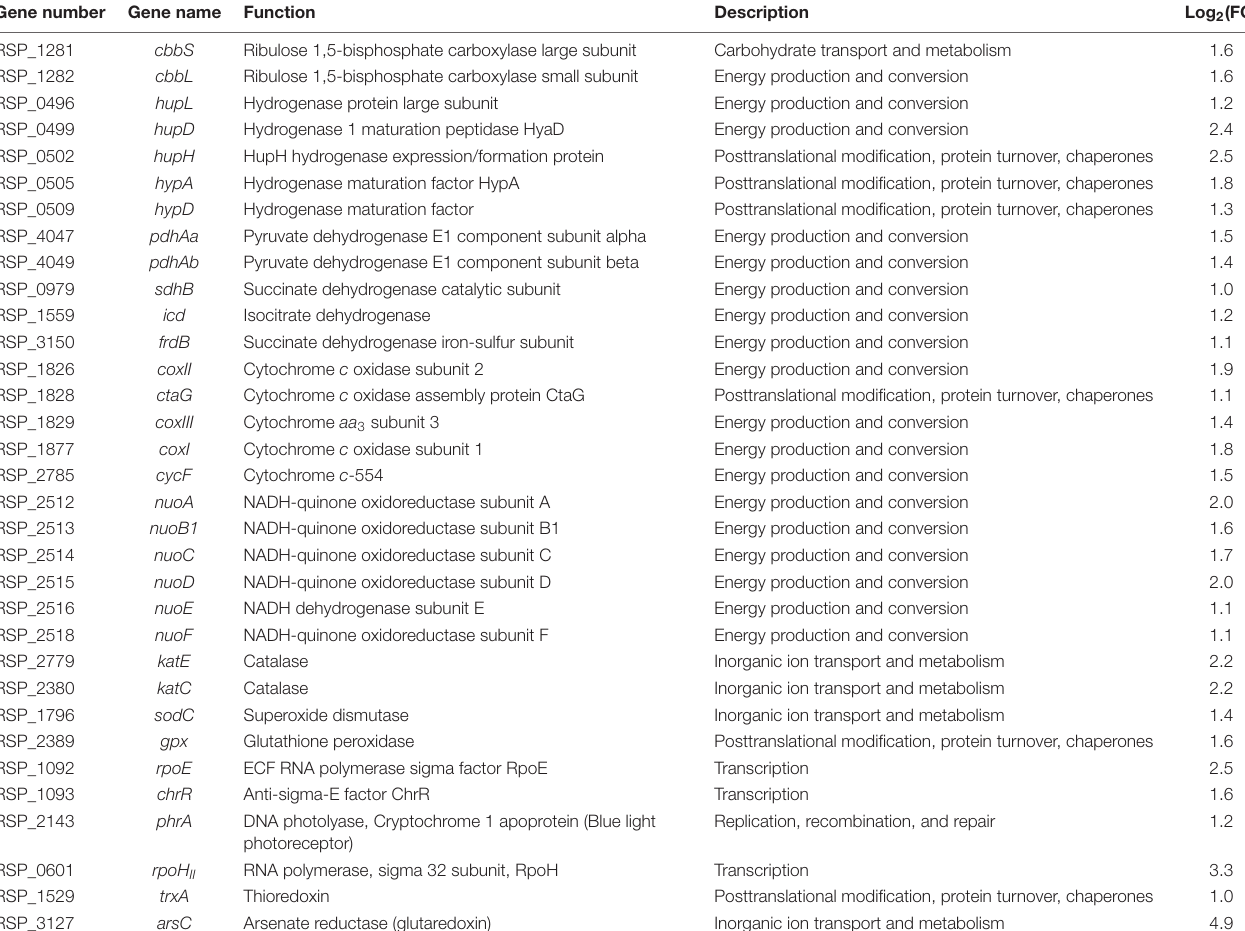
TABLE 3 | Comparison of transcript expression levels in YR-1 vs.